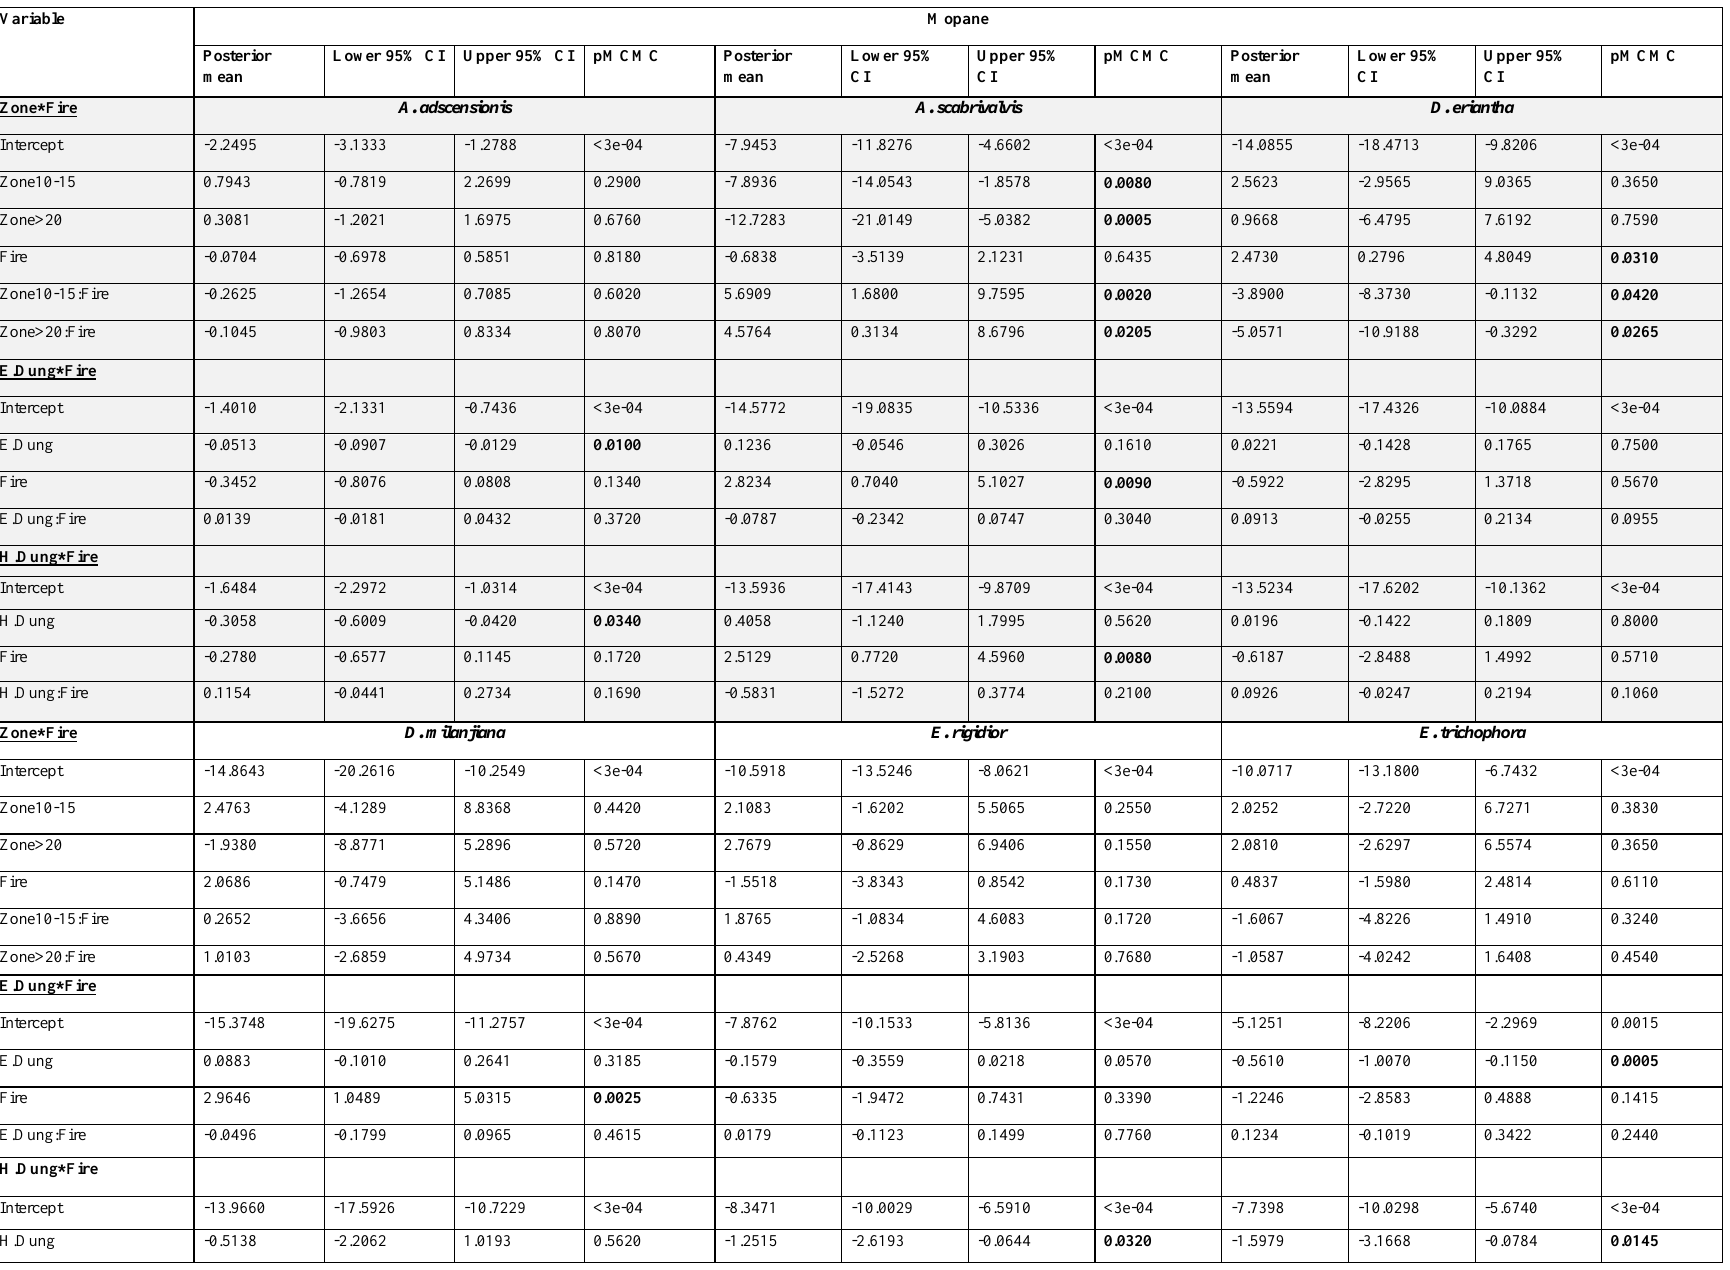
TABLE 3: Grass cover responses. Posterior means, 95% confidence intervals and p -values (< 0.05 in